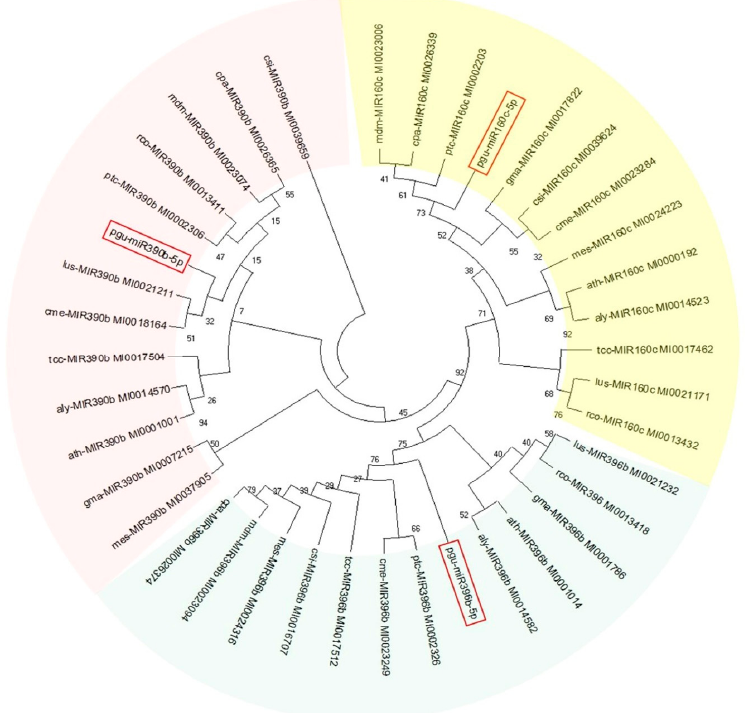
Figure 5. Phylogenetic analysis of the identified guava miRNAs (marked with a red box) pgu-miR160c- 5p , pgu-miR390b-5p , and pgu-miR396b-5p was performed using their potential precursor sequences.